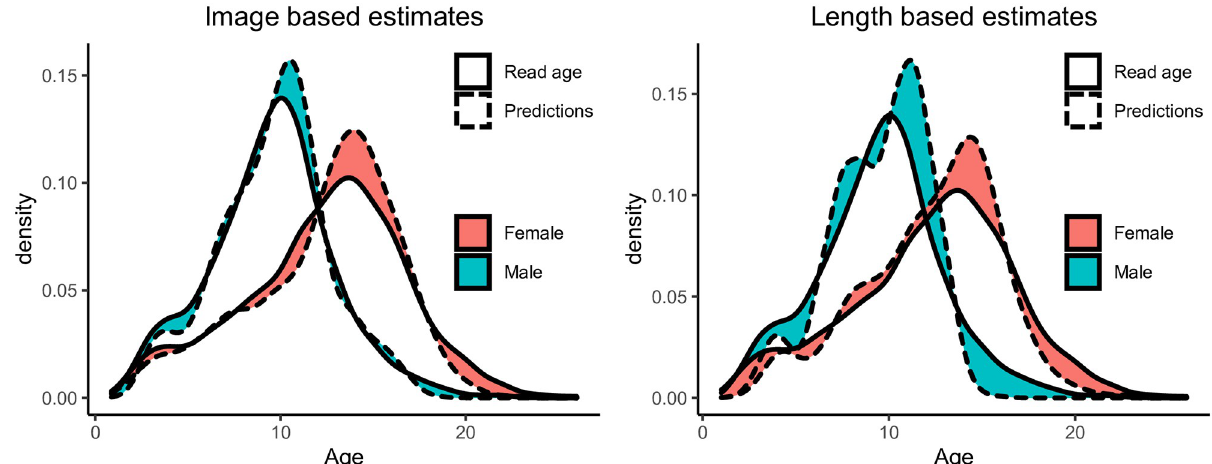
Fig 8. Comparison of age distributions. The figure highlights the difference between the distribution of the read age and the predictions. A: Density estimates for image based predictions. B: Density estimates for length based predictions.